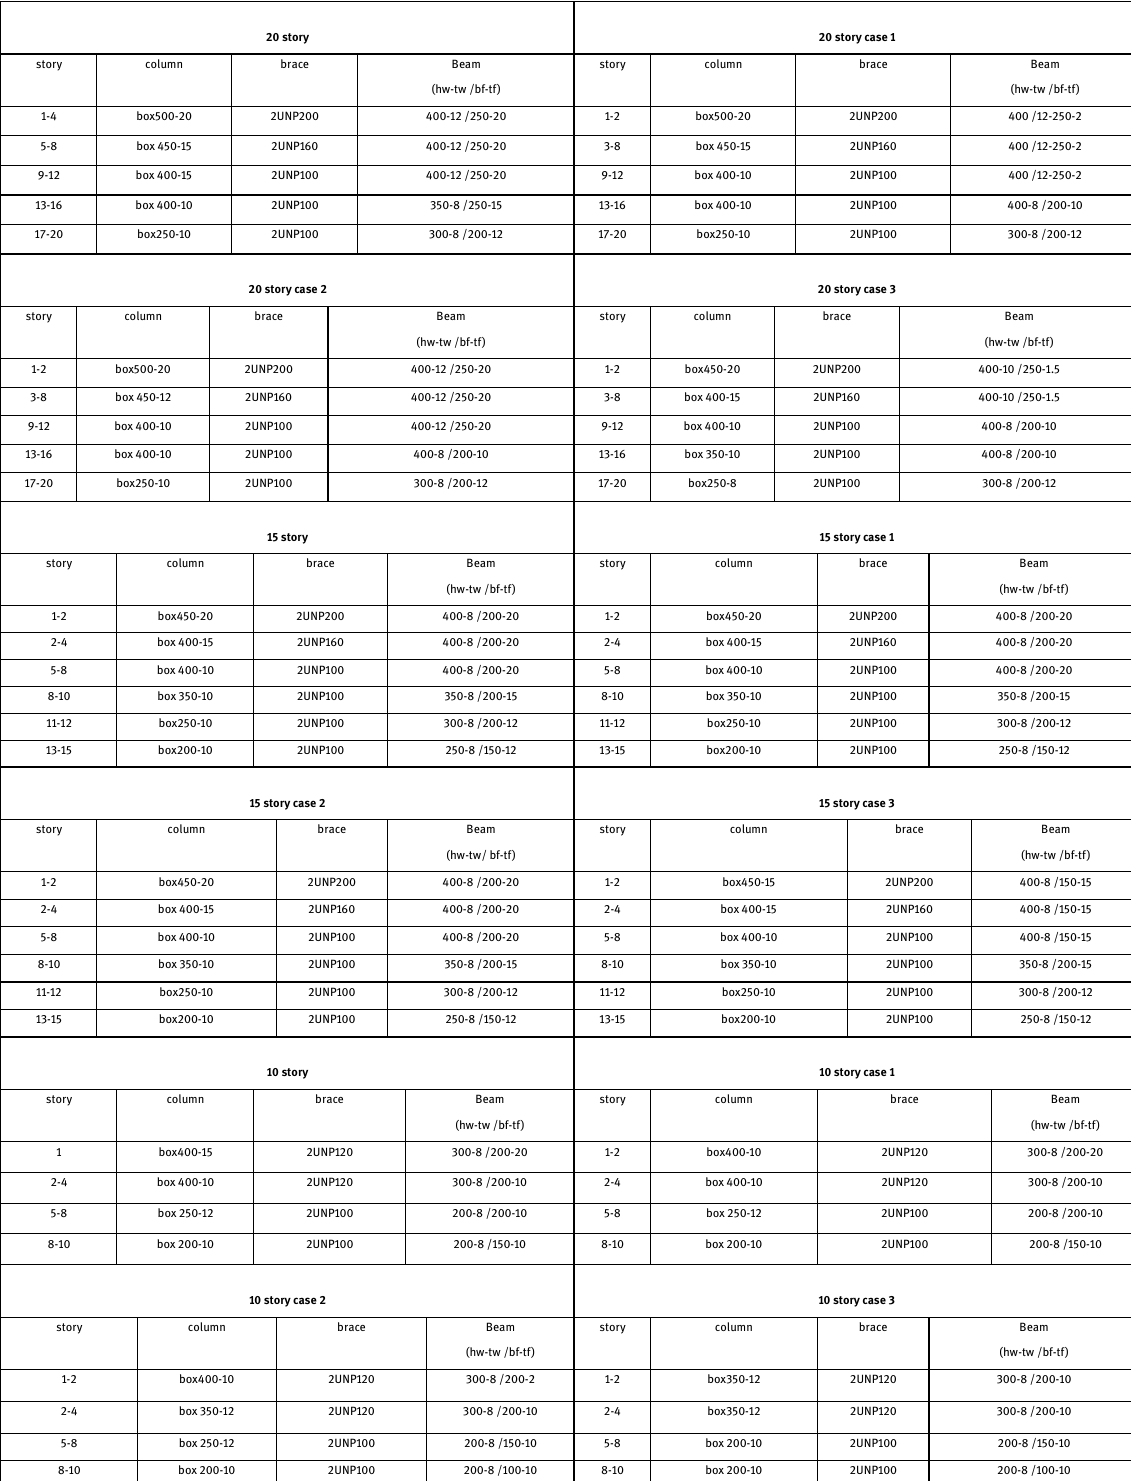
Table 2: Characteristics of structural